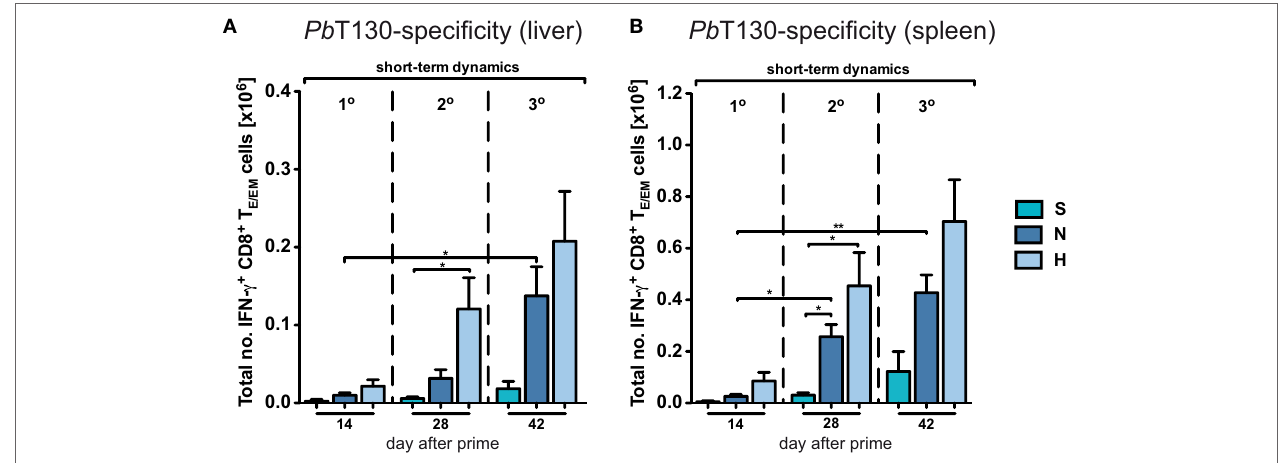
FigUre 3 | Dynamics of antigen-specific CD8 + T E/EM cells after varying Plasmodium berghei RAS vaccination protocols. Antigen-specificity was measured by IFN- γ expression of CD8 + T E/EM cells following overnight-stimulation with Pb T130. The number of IFN- γ expressing T E/EM cells in the liver (a) and spleen (B) of mice receiving different vaccination protocols was determined based on the measured frequencies after overnight-stimulation (Figure S3 in Supplementary Material). Numbers below the plots indicate the time point of measurement in days post prime. Numbers of animals per group are specified within Table S1 in Supplementary Material. Graph bars depict means with SEM; * p < 0.05; ** p < 0.01; *** p < 0.001; multiple nonparametric rank-based relative